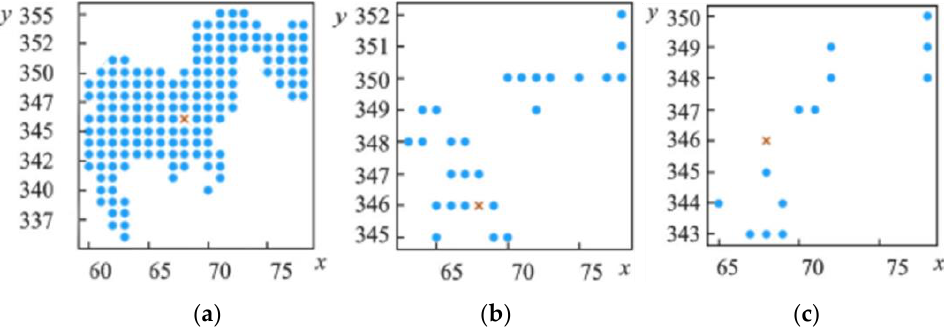
Figure 3. The K-MEANS cluster change diagram of credible data P. ( a ) K = 5, Num = 175, d = 10; ( b ) K = 20, Num = 26, d = 3; ( c ) K = 40, Num = 13, d = 2.